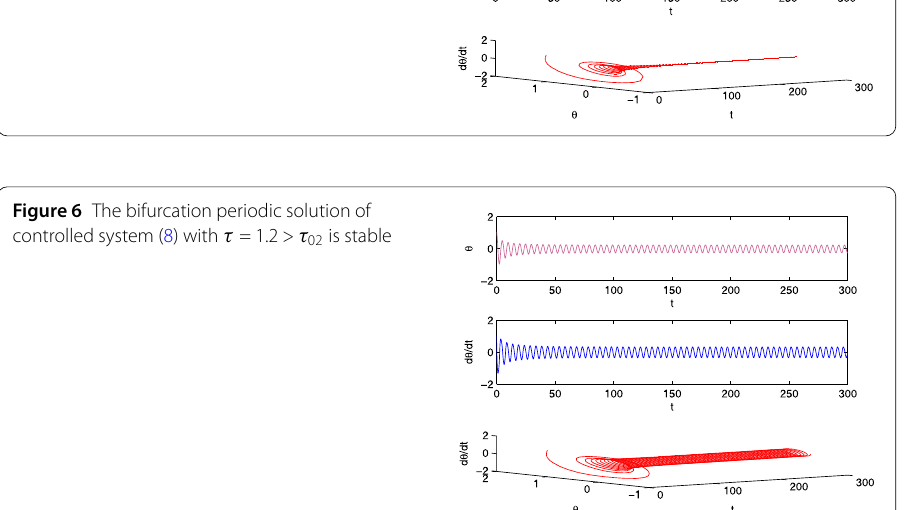
Figure 6 The bifurcation periodic solution of controlled system (8) with τ = 1.2 > τ 02 is